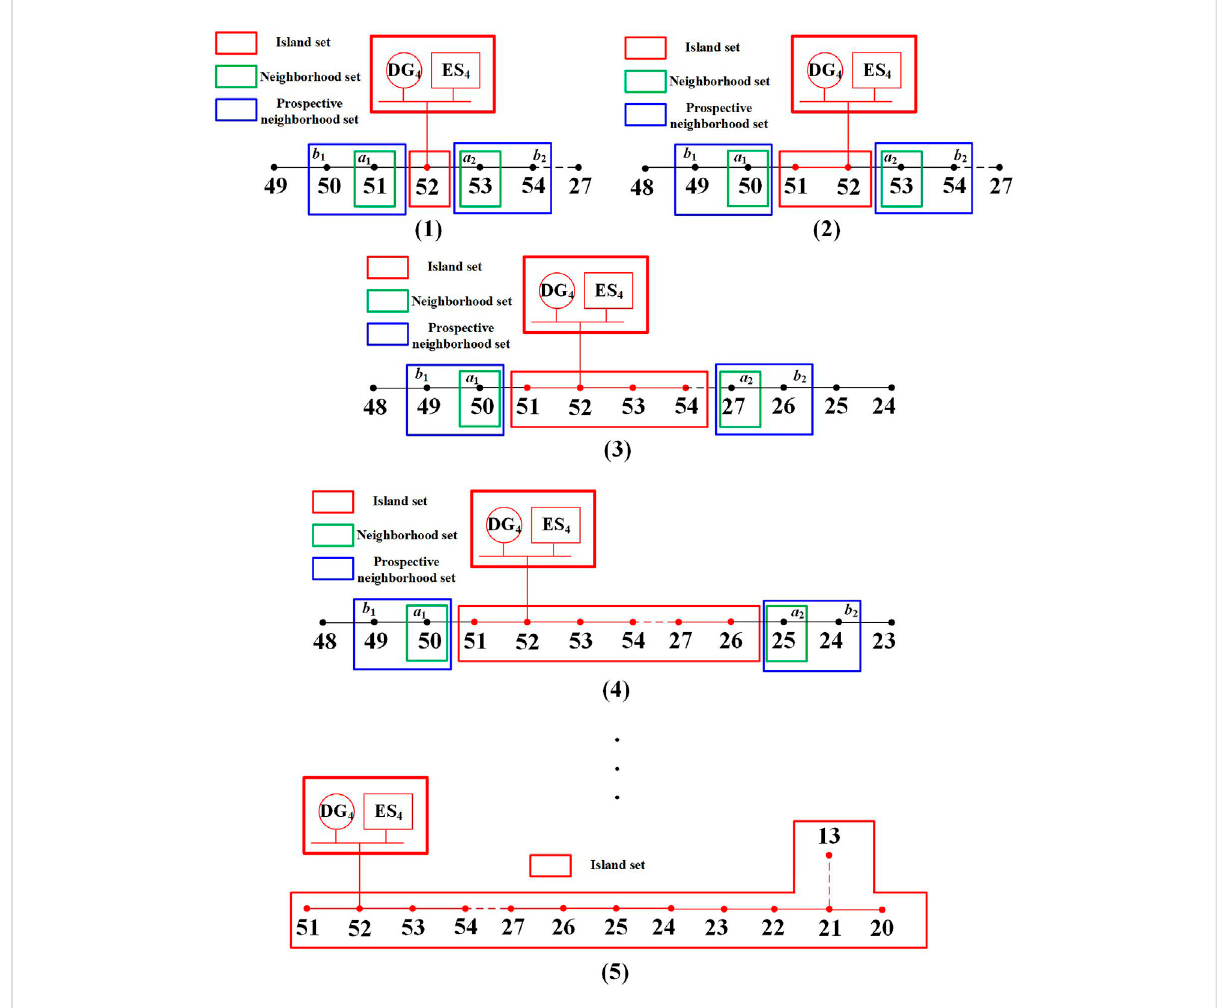
FIGURE 3 The searching process by using the prospective greedy